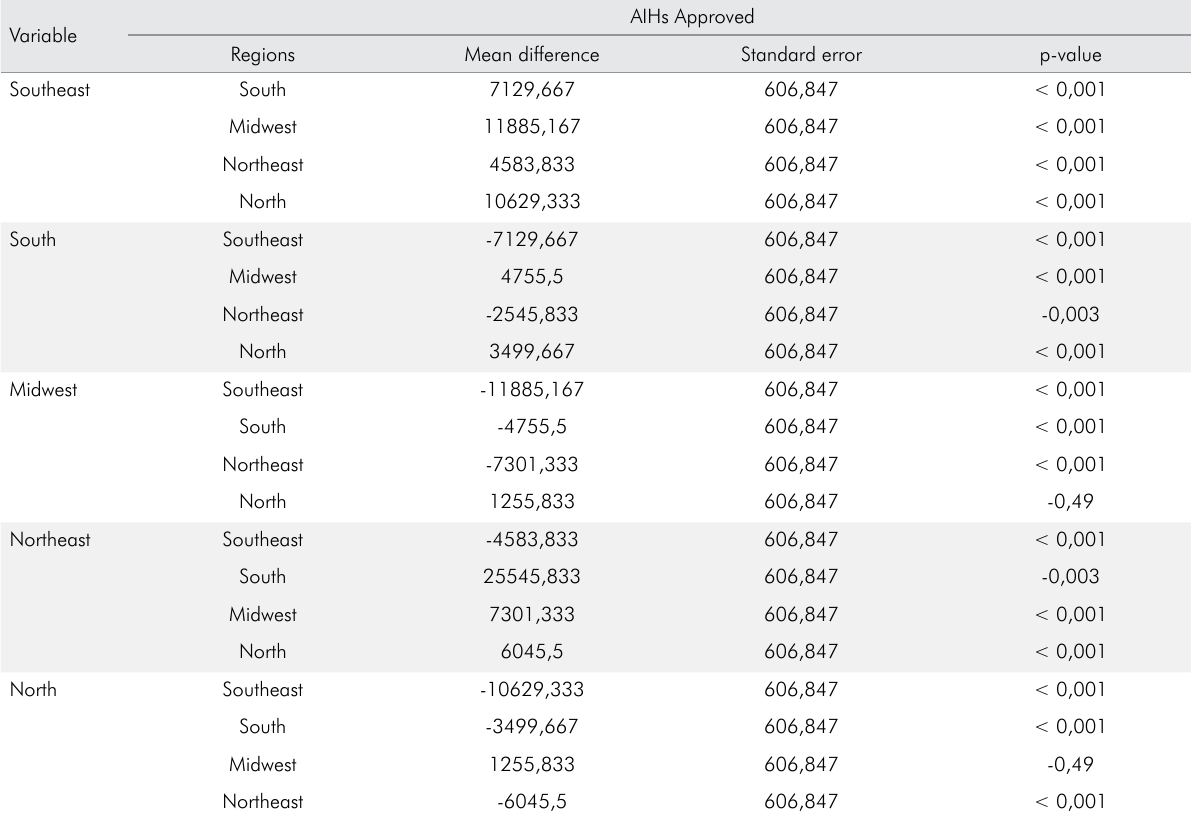
Table 1. Statistical difference in the means of approved procedures between regions